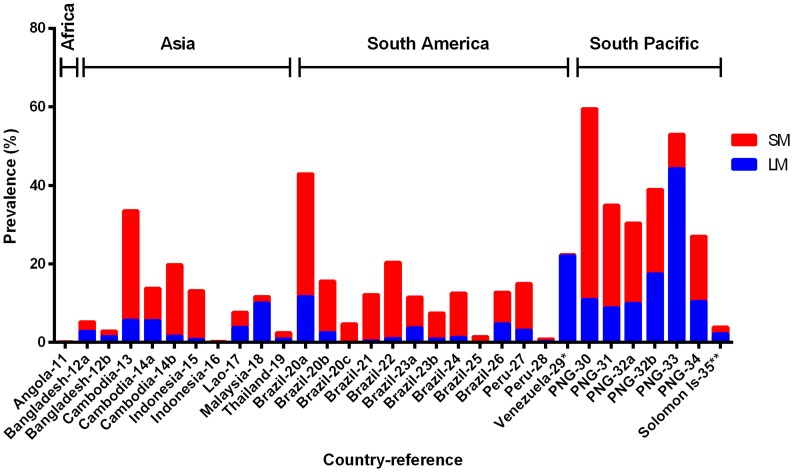
Prevalence of LM (light microscopy, blue bar) and SM (sub-microscopy, red bar) P. vivax in cross-sectional surveys.The total height of each bar (blue + red) represents the PCR prevalence. Countries where data were collected and their corresponding references (detailed in Table 1) are shown on the x-axis.